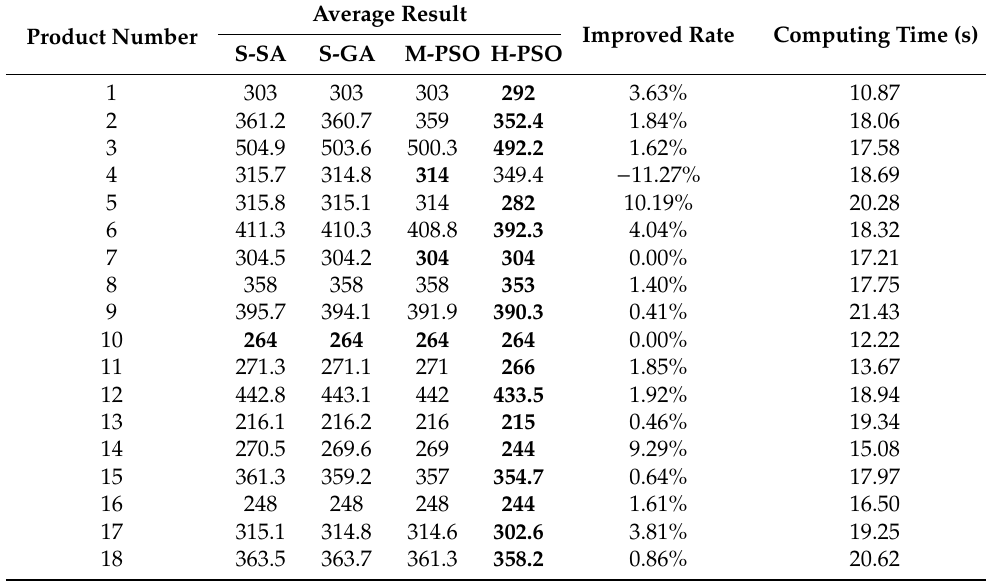
Table 7. The average result comparison of di ff erent algorithms in case 2.